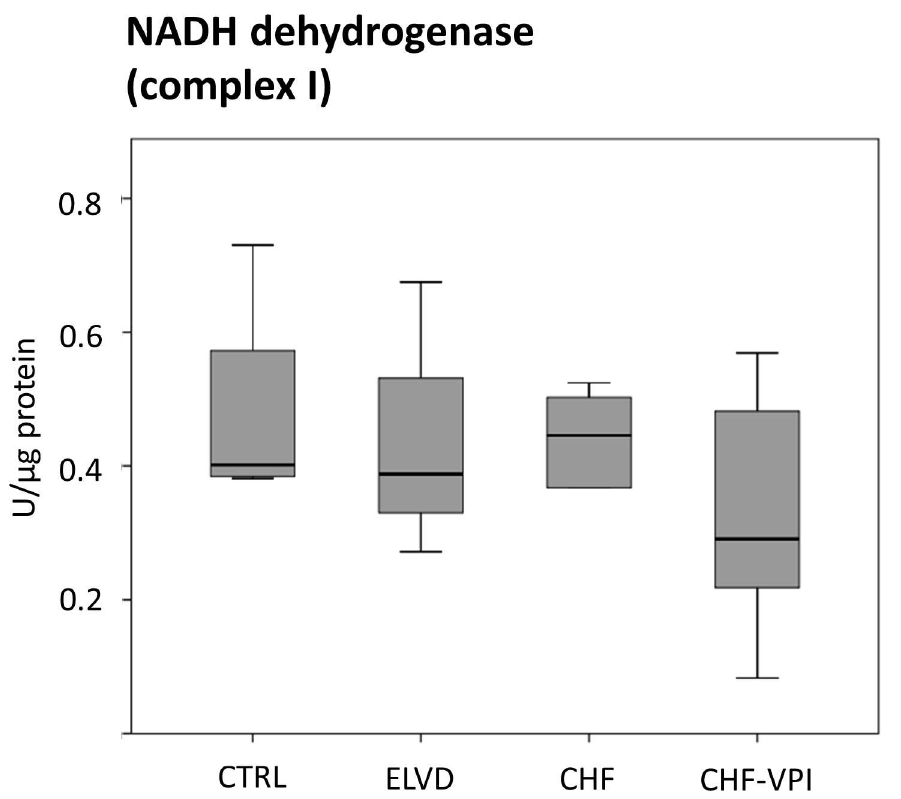
Fig 6. Enzymatic activity of NADH dehydrogenase (ETC complex